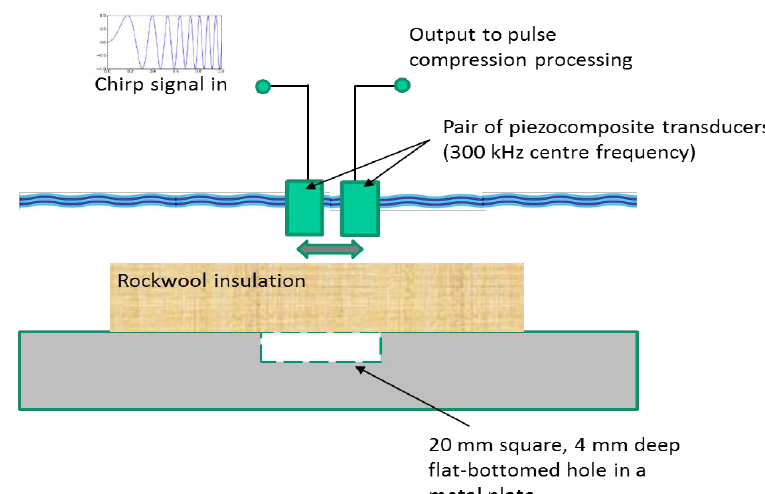
Figure 7. Apparatus used to record pulse compression ultrasonic data from metal surfaces covered in wet insulation layers.